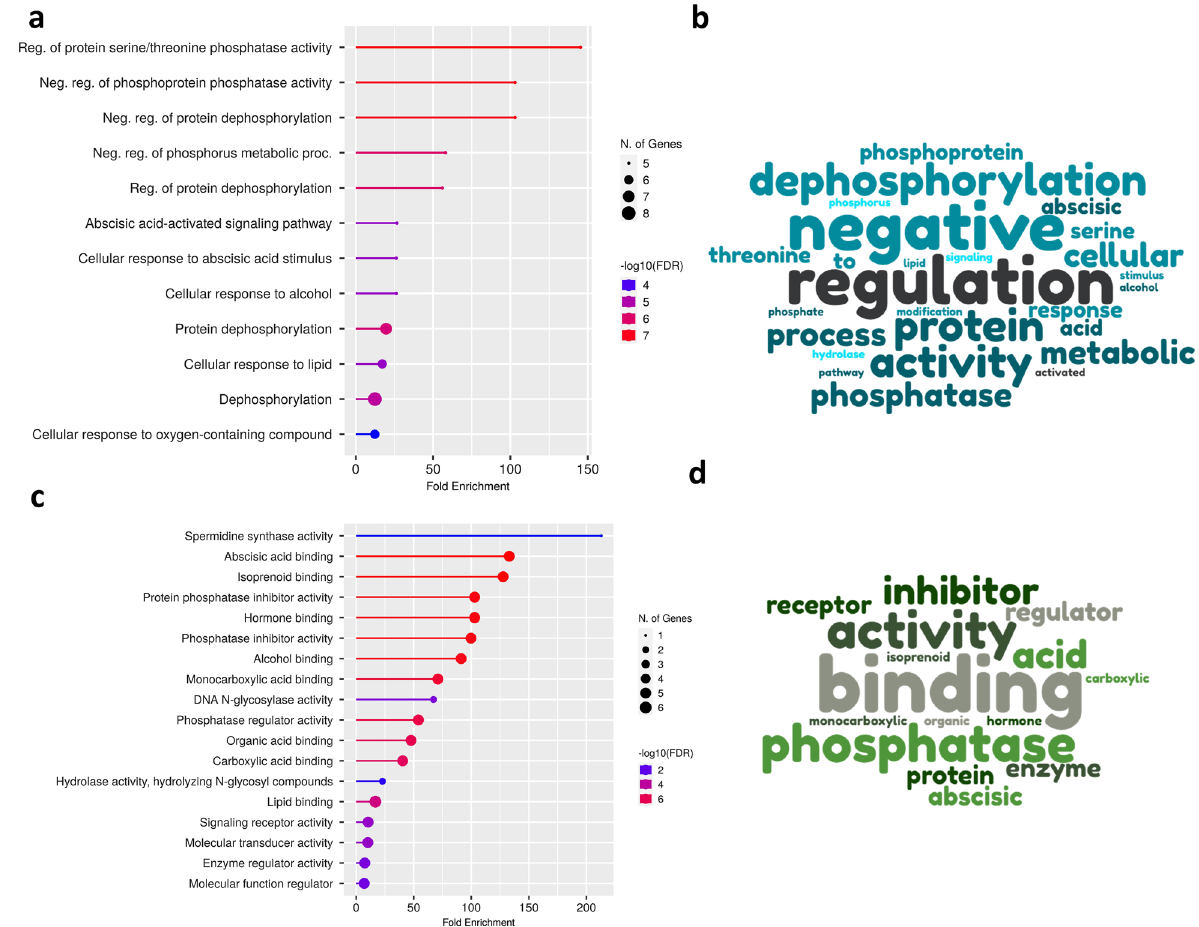
Fig. 7 GO terms enrichment: Biological process a and molecular function c annotations of GO terms obtained from the http:// bioin forma tics. sdsta te. edu/ go database. The representation is limited to the most significant GO terms. Word cloud displaying the most frequent GO terms related to the respective categories of biological process b and molecular function d . The representativeness of a word is defined by its character